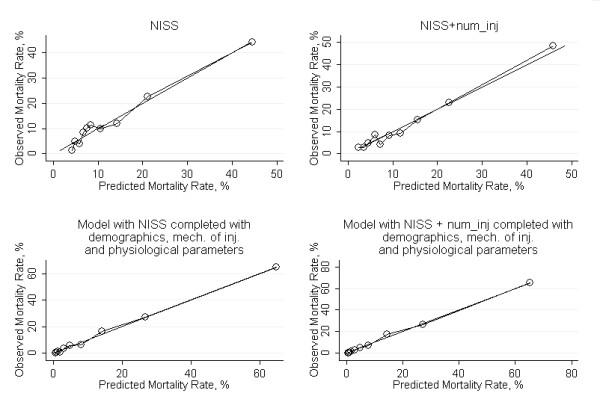
Calibration curves.